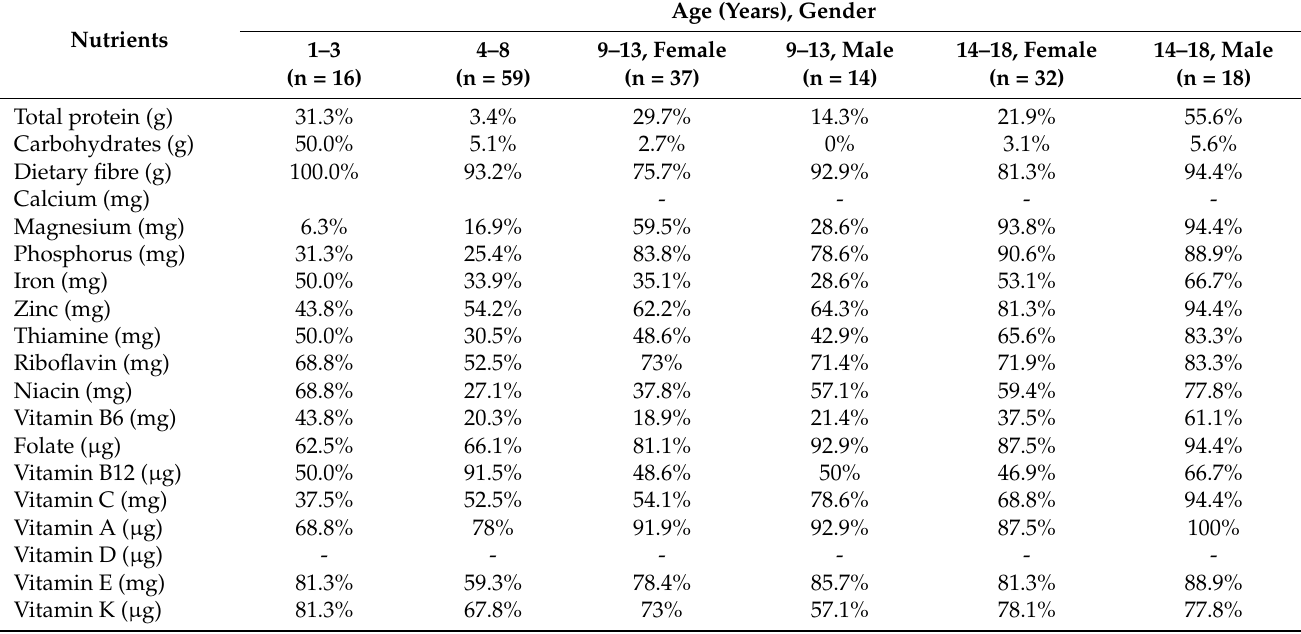
Table 6. The prevalence of inadequate nutrient intake for each age and gender